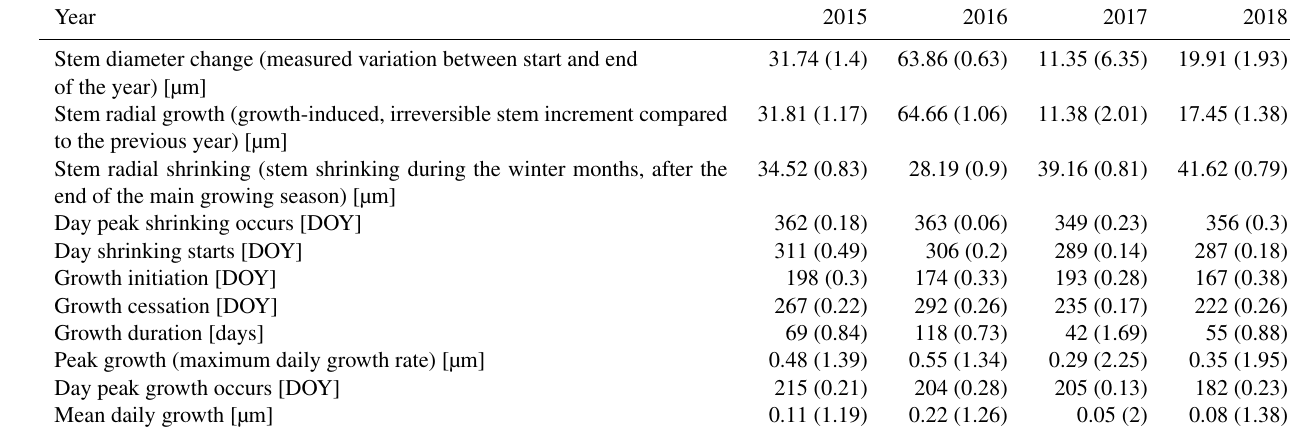
Table 3. Parameters of stem change (means). Numbers in parentheses represent variability between specimens (coefficient of variation,